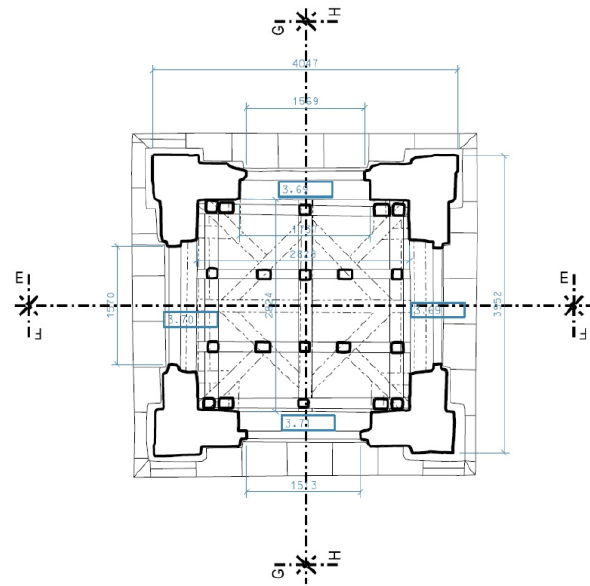
Figure 19. Horizontal section view